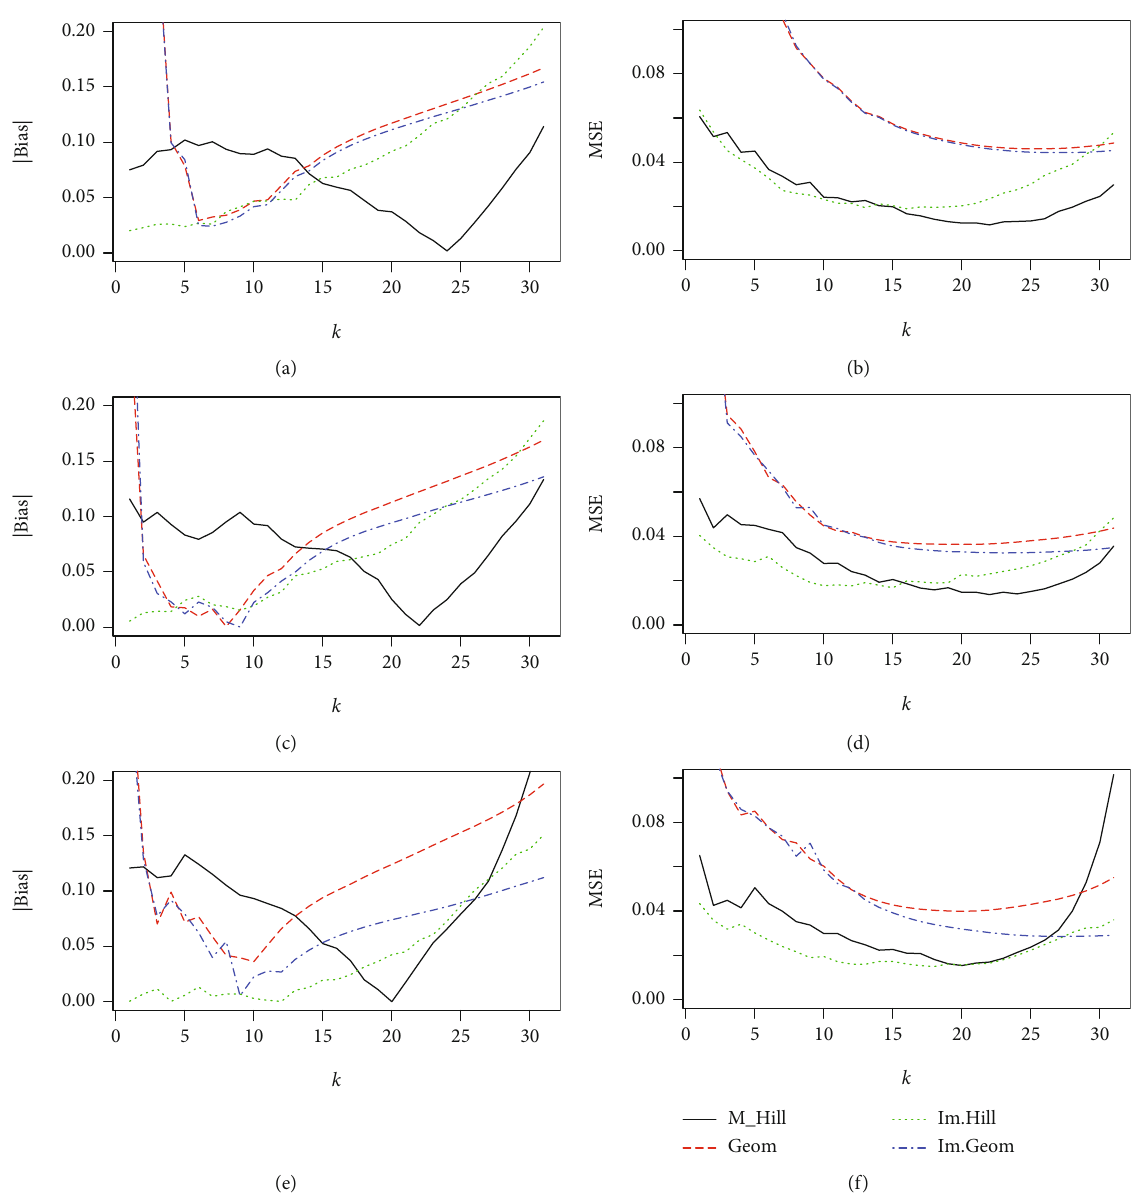
Figure 2: Results of ̂ ξ ð k Þ from Burr distribution with n = 50 . (a, c, and e) Absolute bias. (b, d, and f) MSE. (a, b), (c, d), and (e, f) are 10%, 30%, and 60% missingness,